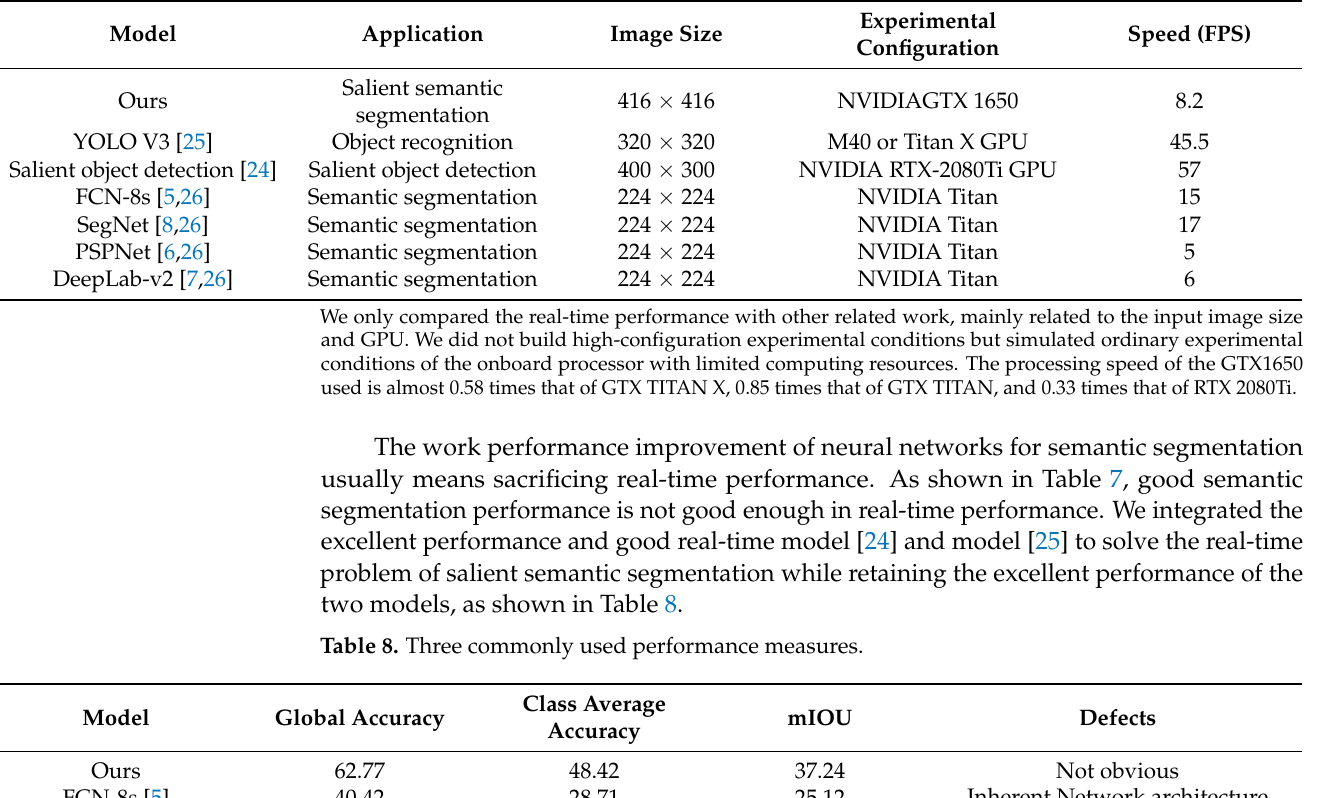
Table 7. Average Speed comparison of the related model architectures.